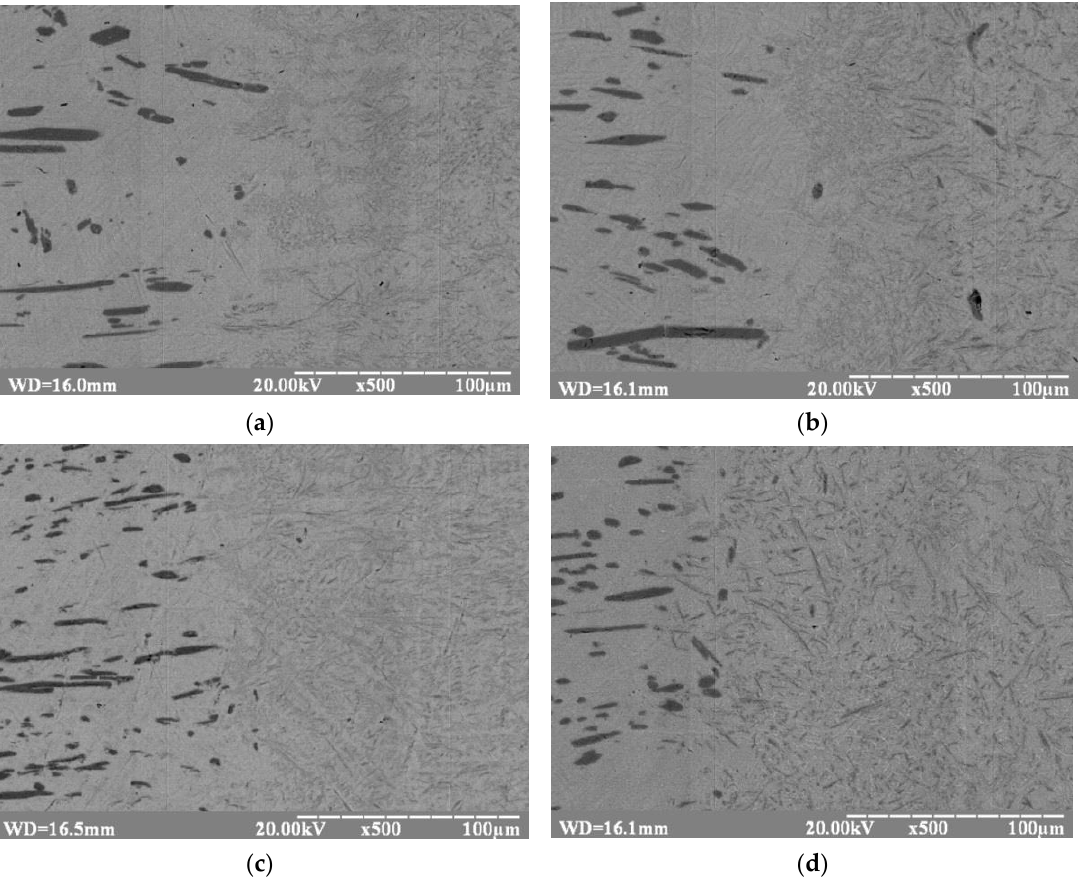
Figure 6. Structure of the material in the area of base material transition into weld metal: ( а ) sample of number 1 series; ( b ) sample of number 2 series; ( c ) sample of number 3 series; ( d ) sample of number 4 series.